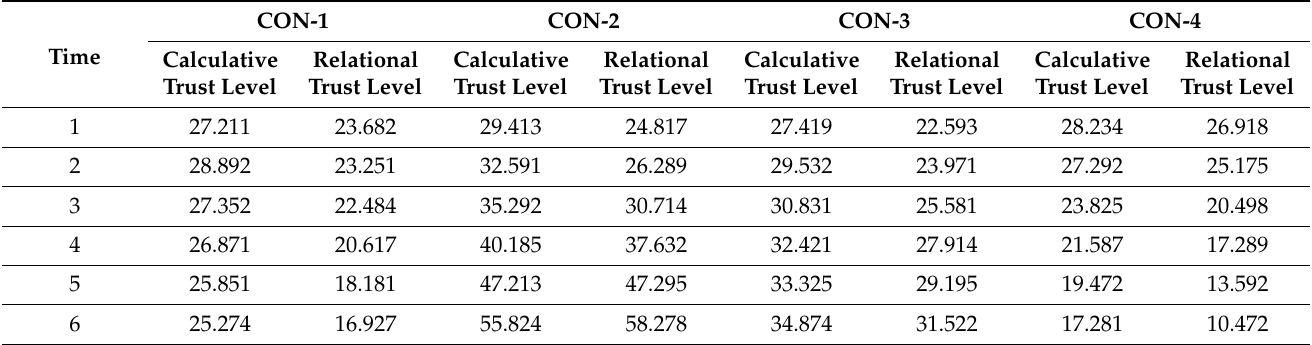
Table 7. Scenario F simulation